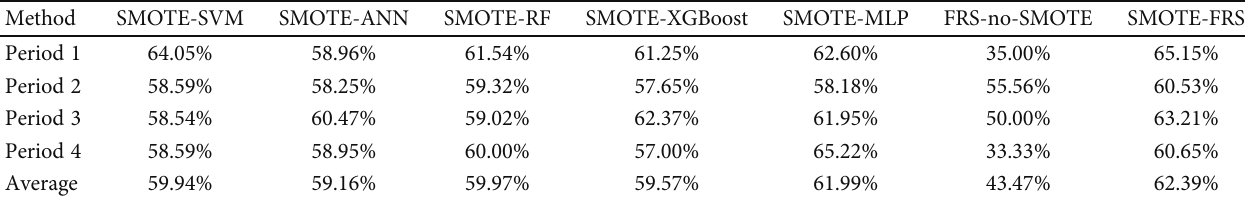
Table 7: The hit ratio results of the benchmarks and the proposed method SMOTE-FRS.